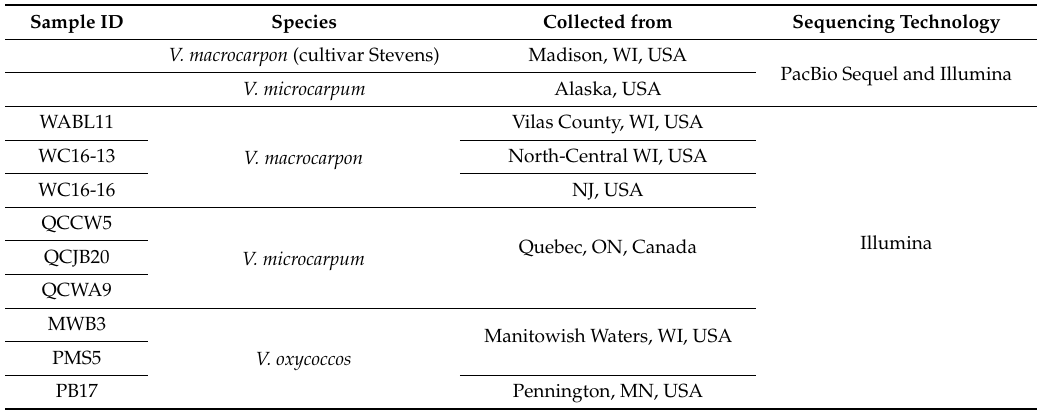
Table 1. Vaccinium samples sequenced and assembled in this